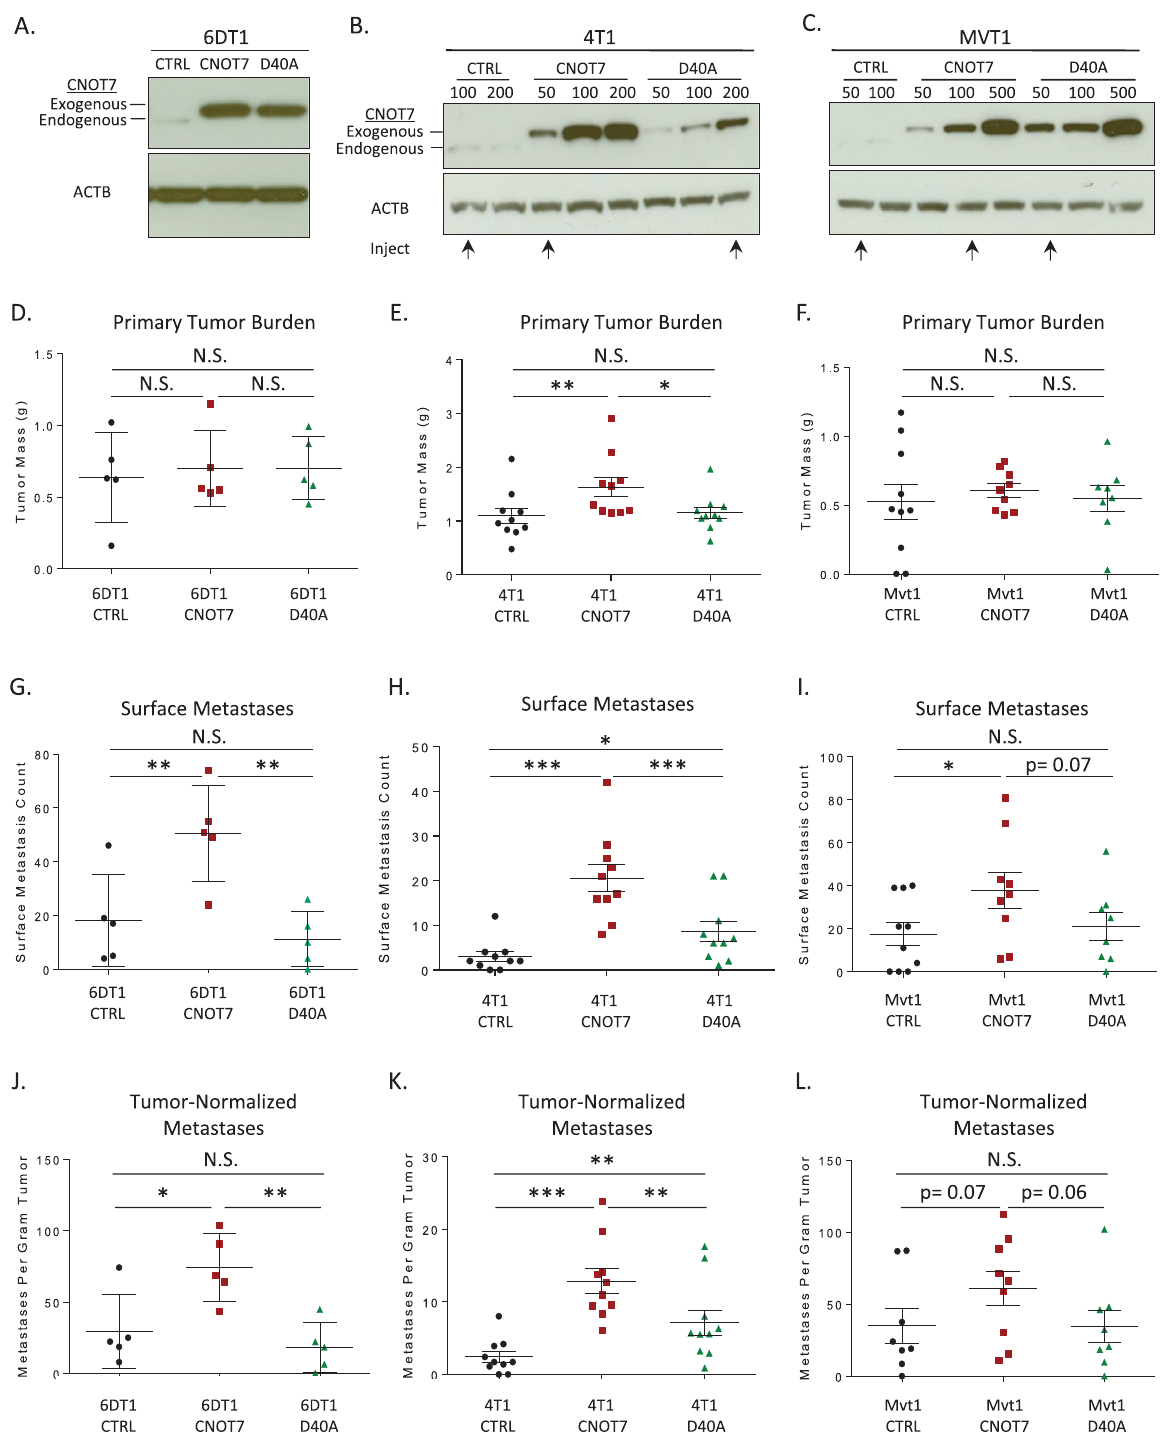
Fig 5. Western blots showing the relative expression of exogenously expressed CNOT7 and the D40A mutant in 6DT1 (A), 4T1 (B) and Mvt1 (C). The ectopically expressed CNOT7 migrates slightly higher than the endogenous band due to the addition of the FLAG epitope tag. The cell lines injected for 4T1 and Mvt1 experiments are indicated below the panels by arrows. Primary tumor burden for the CNOT7 or D40A mutant cell lines are indicated in panels D-F. Surface pulmonary metastases (G-I) and metastases normalized for primary tumor mass (J-L) are displayed on the last two rows of the figure. N.S. = not significantly different. * = p < 0.05; ** = p < 0.01; *** = p <